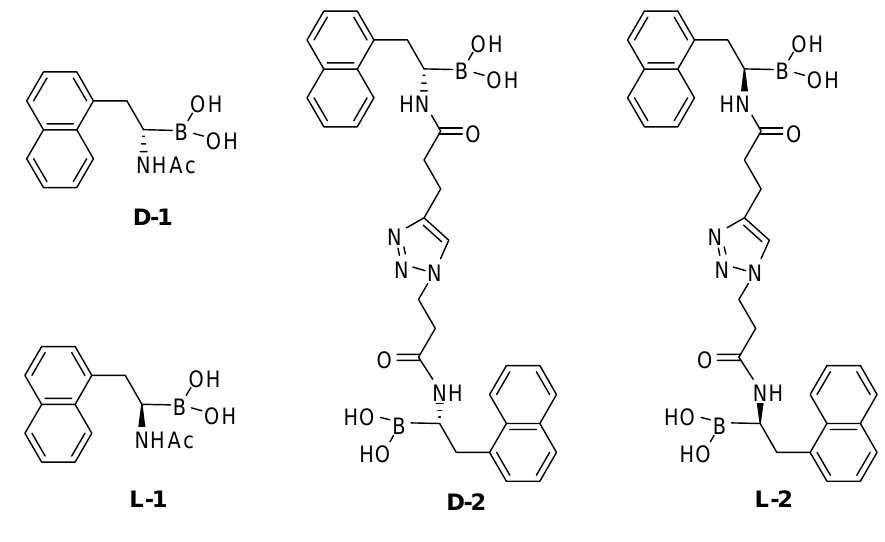
Figure 1. Enatiomeric pairs of α -amidoboronic acids and the corresponding bisboronic